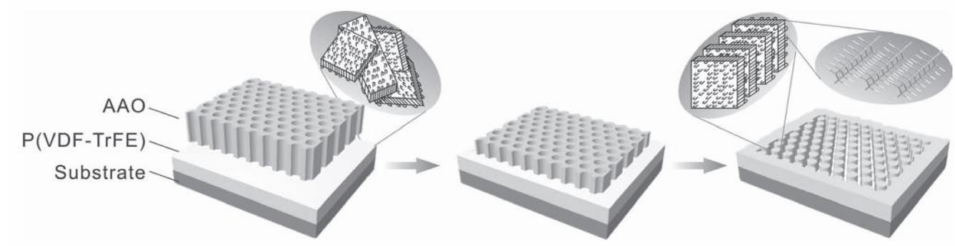
Figure 8. Procedure of nano-imprinting P(VDF-TrFE) using AAO (Reproduced with permission from [54]. Copyright Wiley and sons,